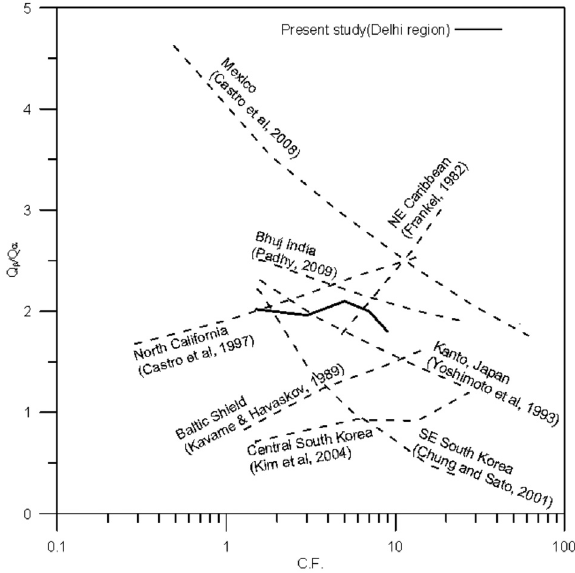
Figure 8. Comparison of the ratio Q b / Q a estimated at different fre- quencies with those of other tectonic regions of India and